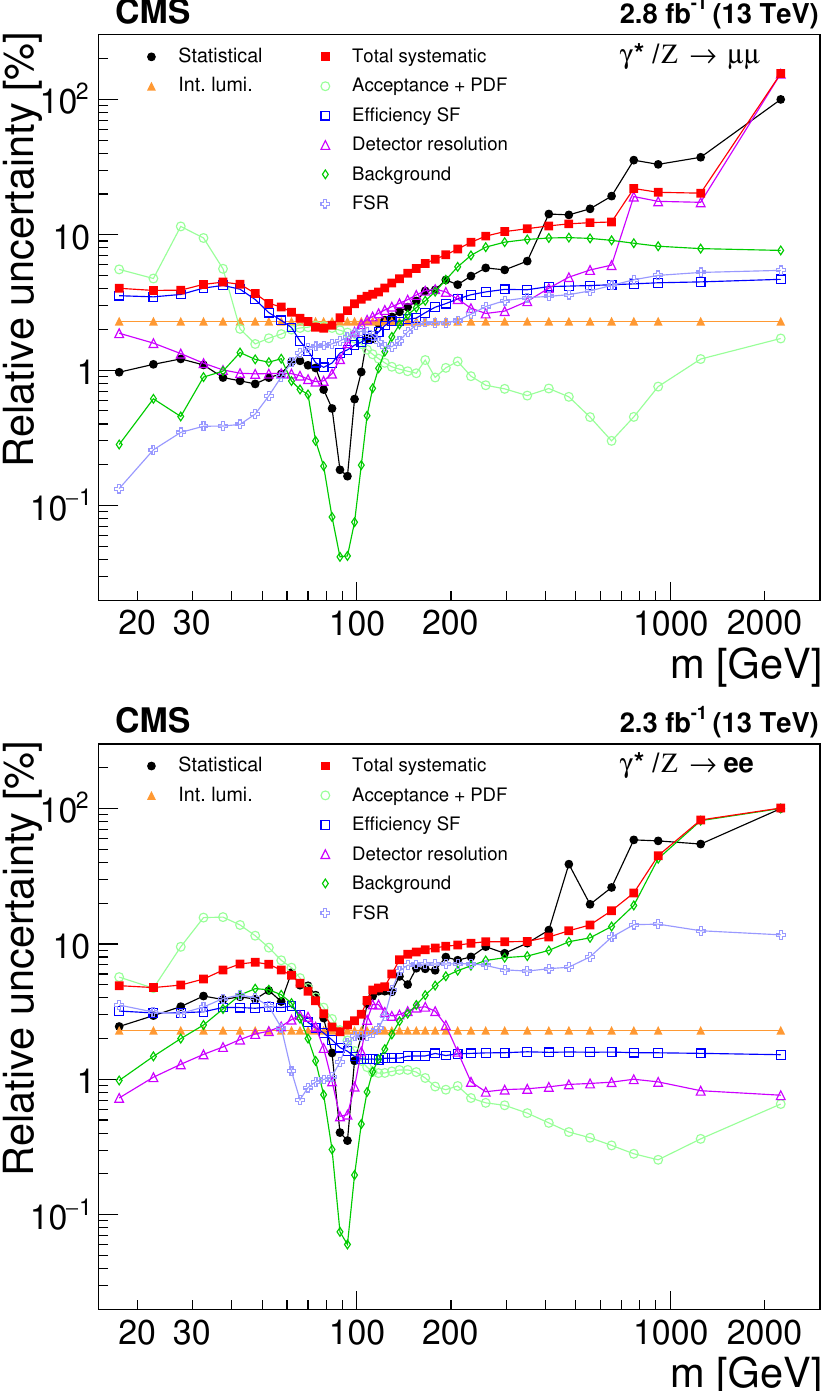
Figure 3 . Summary of the systematic uncertainties on the di(cid:11)erential cross section measurement d (cid:27)= d m [pb/GeV] in the dimuon (upper) and dielectron (lower) channels. The \Total systematic" is a quadratic sum of all systematic uncertainty sources except for the \Acceptance + PDF".